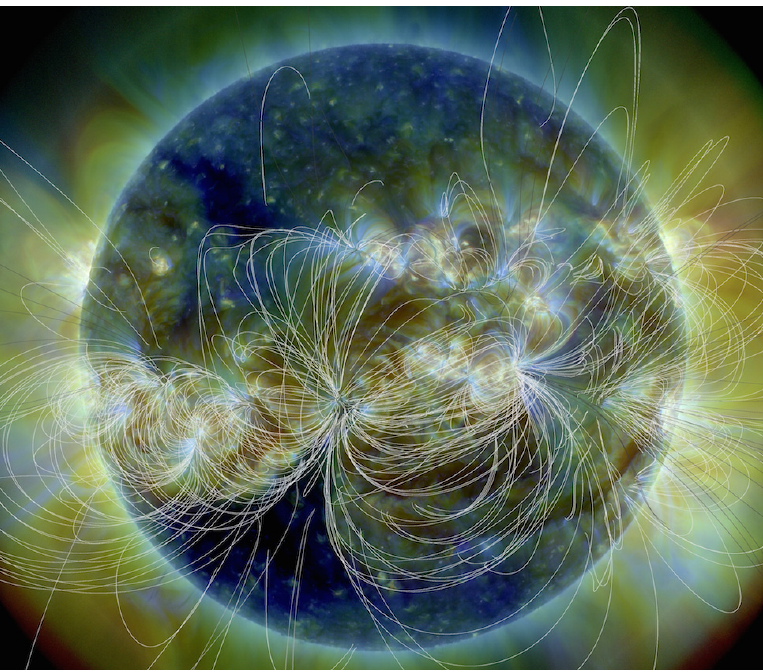
Figure 4: Magnetic field lines extrapolated from optical magnetogram superposed on a composite SDO/AIA (211 ˚A, 193 ˚A, 171 ˚A) image, on 7 April 2014. Credit: